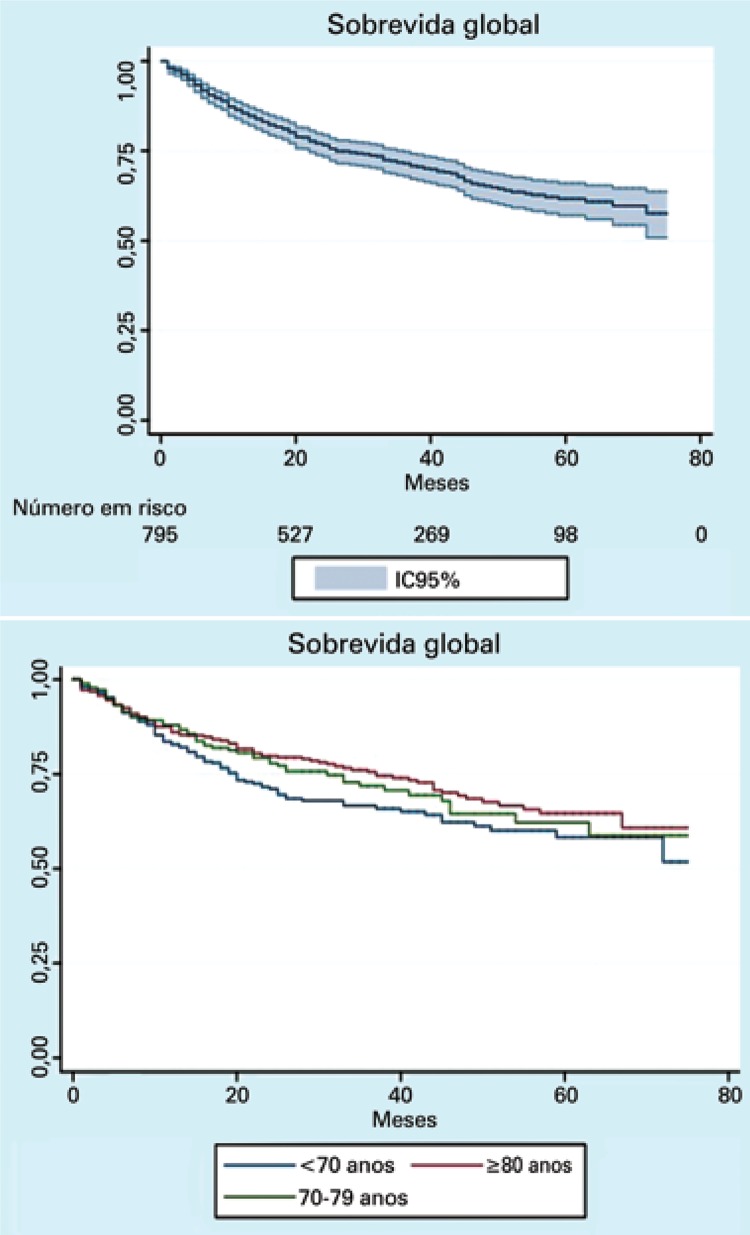
Sobrevida global específica para idade em pacientes idosos com diagnóstico de tumor sólido, no Hospital Israelita Albert Einstein, São Paulo, Brasil (2007-2011)